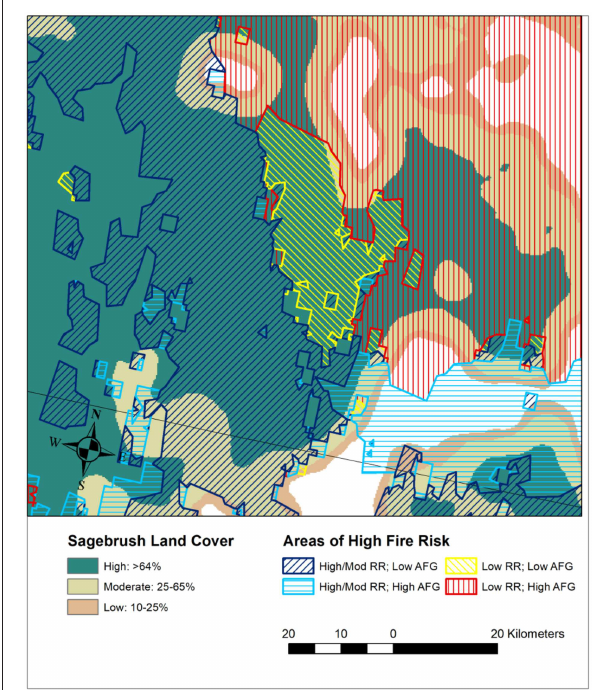
FIGURE 13 | A map of an area on the Idaho/Nevada border that overlays relative sagebrush dominance with areas of high to very high fire risk that have (1) high to moderate resilience and resistance and low annual forb and grass cover, (2) high to moderate resilience and resistance and high annual forb and grass cover, (3) low resilience and resistance and low annual forb and grass cover, and (4) low resilience and resistance and high annual forb and grass cover. The geospatial data sources are described in Figure 12 . Areas with high cover of sagebrush that have low resilience and resistance, high fire risk, and low cover of annual forbs and grasses are among the highest priorities for protective management strategies, such as conservation easements and early detection and rapid response management of invasive plants. Areas with moderate cover of sagebrush that have high to very high fire risk are areas to consider for treatments that will increase connectivity and resilience to wildfire, such as fuel treatments, fuel breaks, and seeding after wildfires. Areas with low cover of sagebrush may have limited ability to support desired resources and habitats and where associated with high levels of invasion or human development, fire prevention, preparedness, and suppression may be high